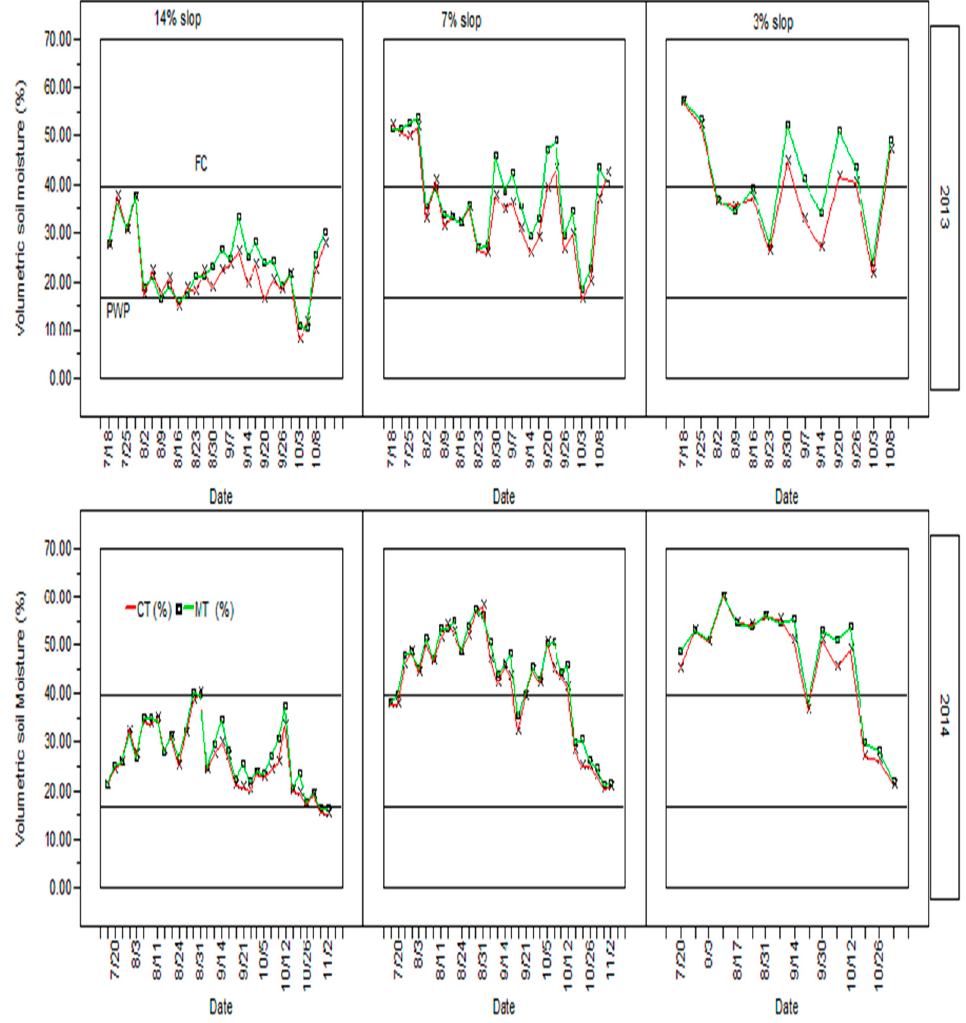
Figure 7. Effect of tillage practices on the average soil water content of maize-planted fields for the top 0 to 20 cm depth during year 1 ( left ) and year 2 ( right ) cropping seasons.